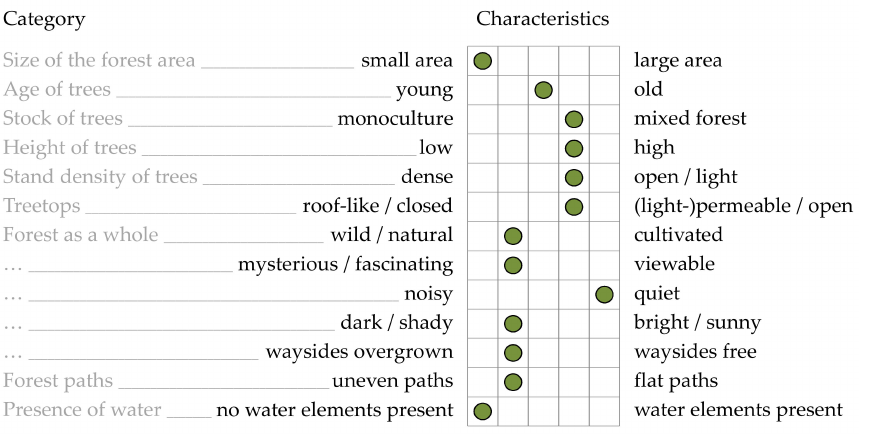
Figure 1. Exemplary forest profile based on presented evaluation approach (Source: own